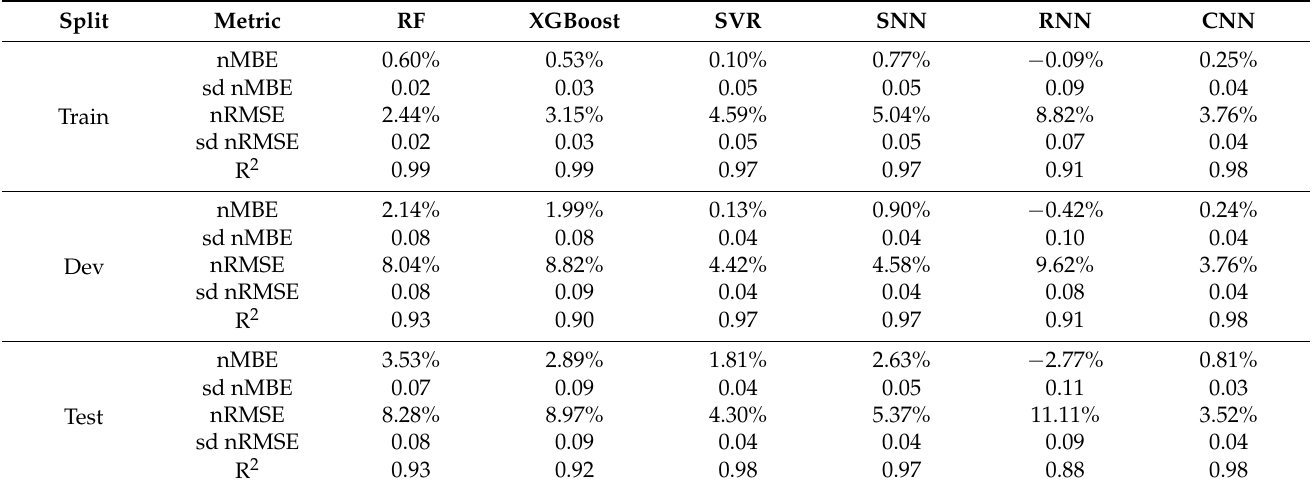
Table 2. Averaged error obtained with the cross-validation method in different Artificial Intelligence methods without night consideration.